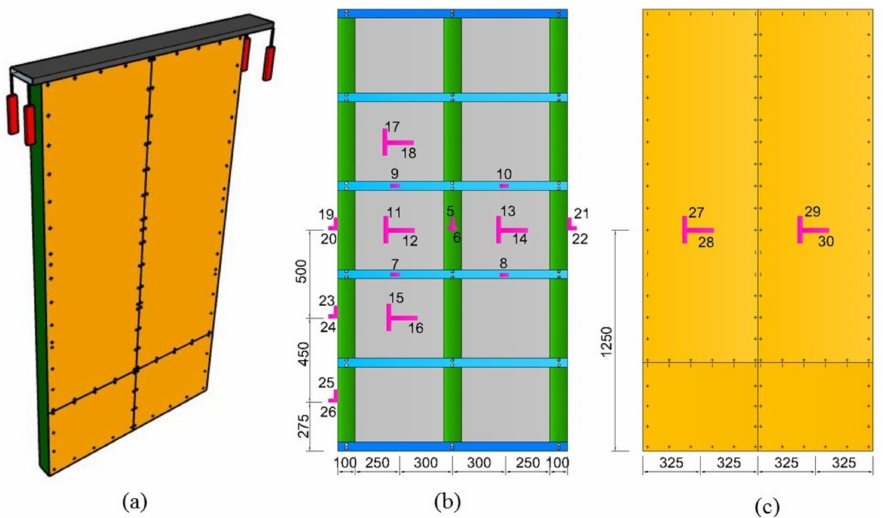
Figure 4. Arrangement of measuring instruments. ( a ) Locations of LVDTs; ( b ) locations of the studs and PG gauges; ( c ) locations of sheathing